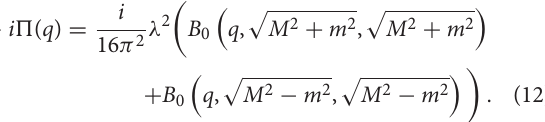
correspond, respectively, to the leading order (LO) with no mass insertions, and to the next to leading order (NLO) with